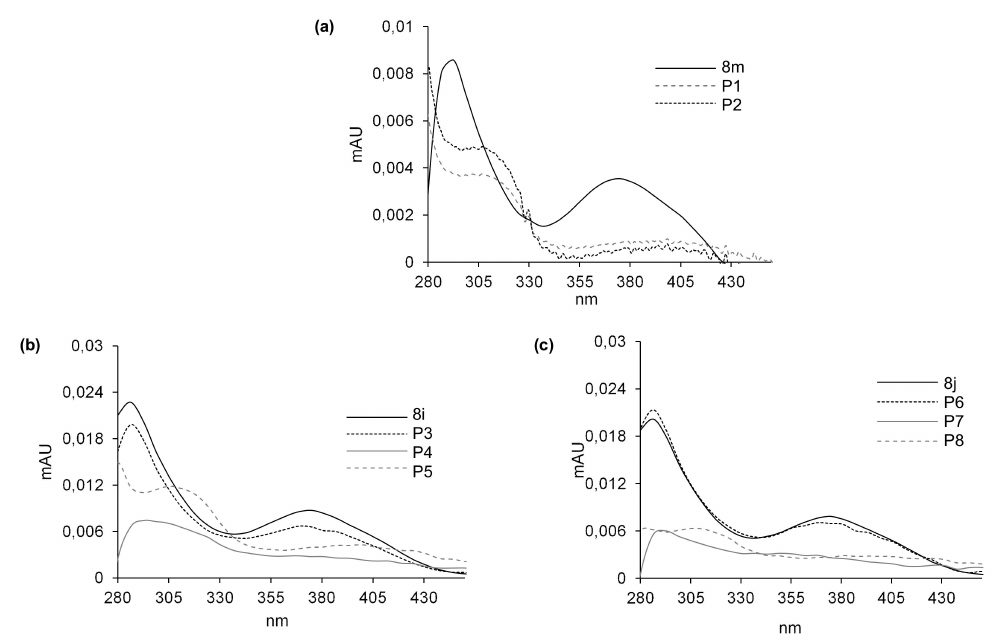
Figure 5. UV-Vis spectra of the metabolites of 8m ( a ), 8i ( b ) and 8j ( c ) formed with RLM and NADPH. Spectra were recorded directly during HPLC analysis by means of a multidiode array detector in an ammonium formate pH 3.4/methanol mobile